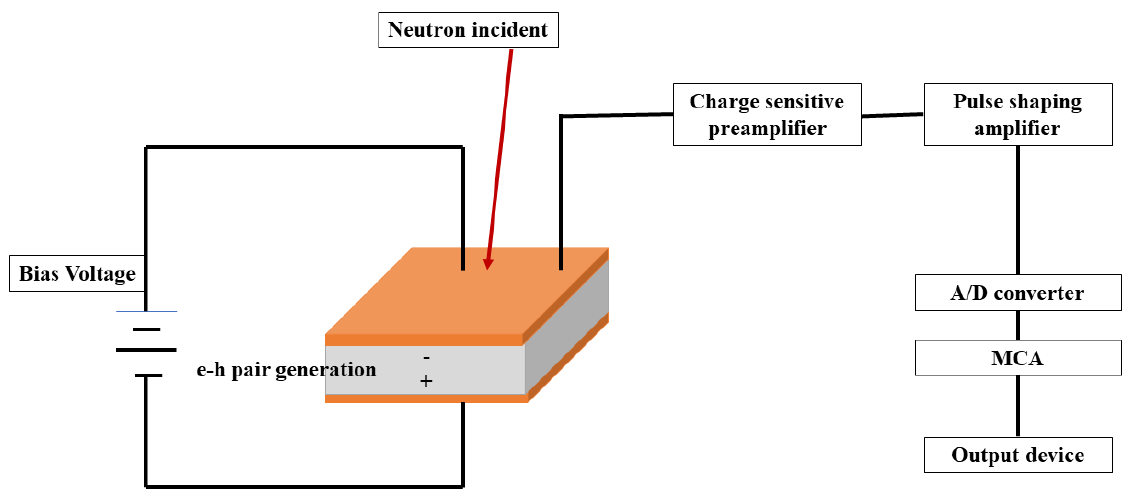
Figure 6. Schematic for the readout electronics